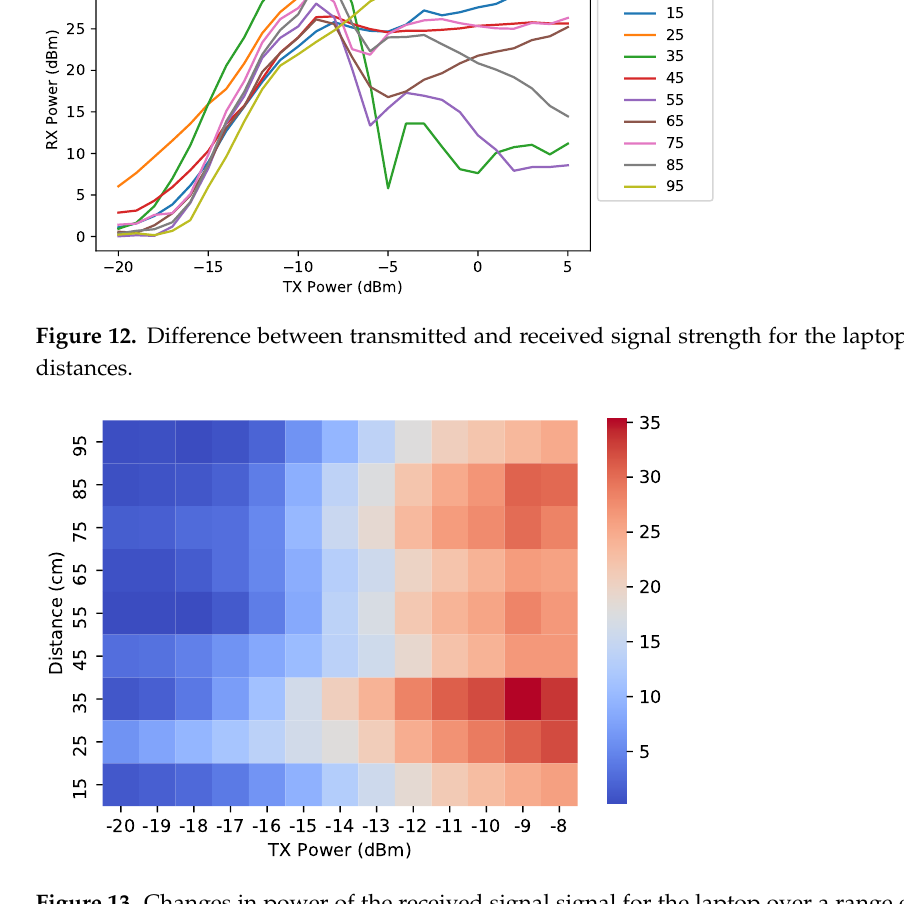
Figure 13. Changes in power of the received signal signal for the laptop over a range of distances and transmitted power. In a gradient, deeper red indicates a stronger harmonic signal and deeper blue means the received signal was indistinguishable from